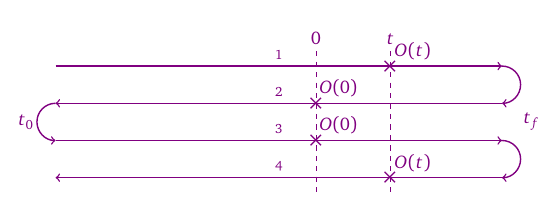
Figure 4: Contour-ordered correlator for 〈 O ( t ) O ( 0 ) O ( 0 ) O ( t ) 〉 where t > 0